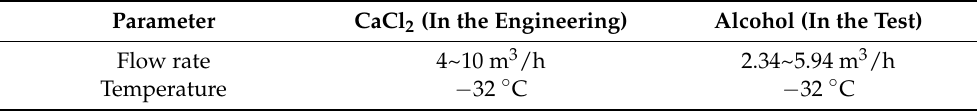
Table 4. Flow rate conversion of low temperature refrigerant of engineering and test.